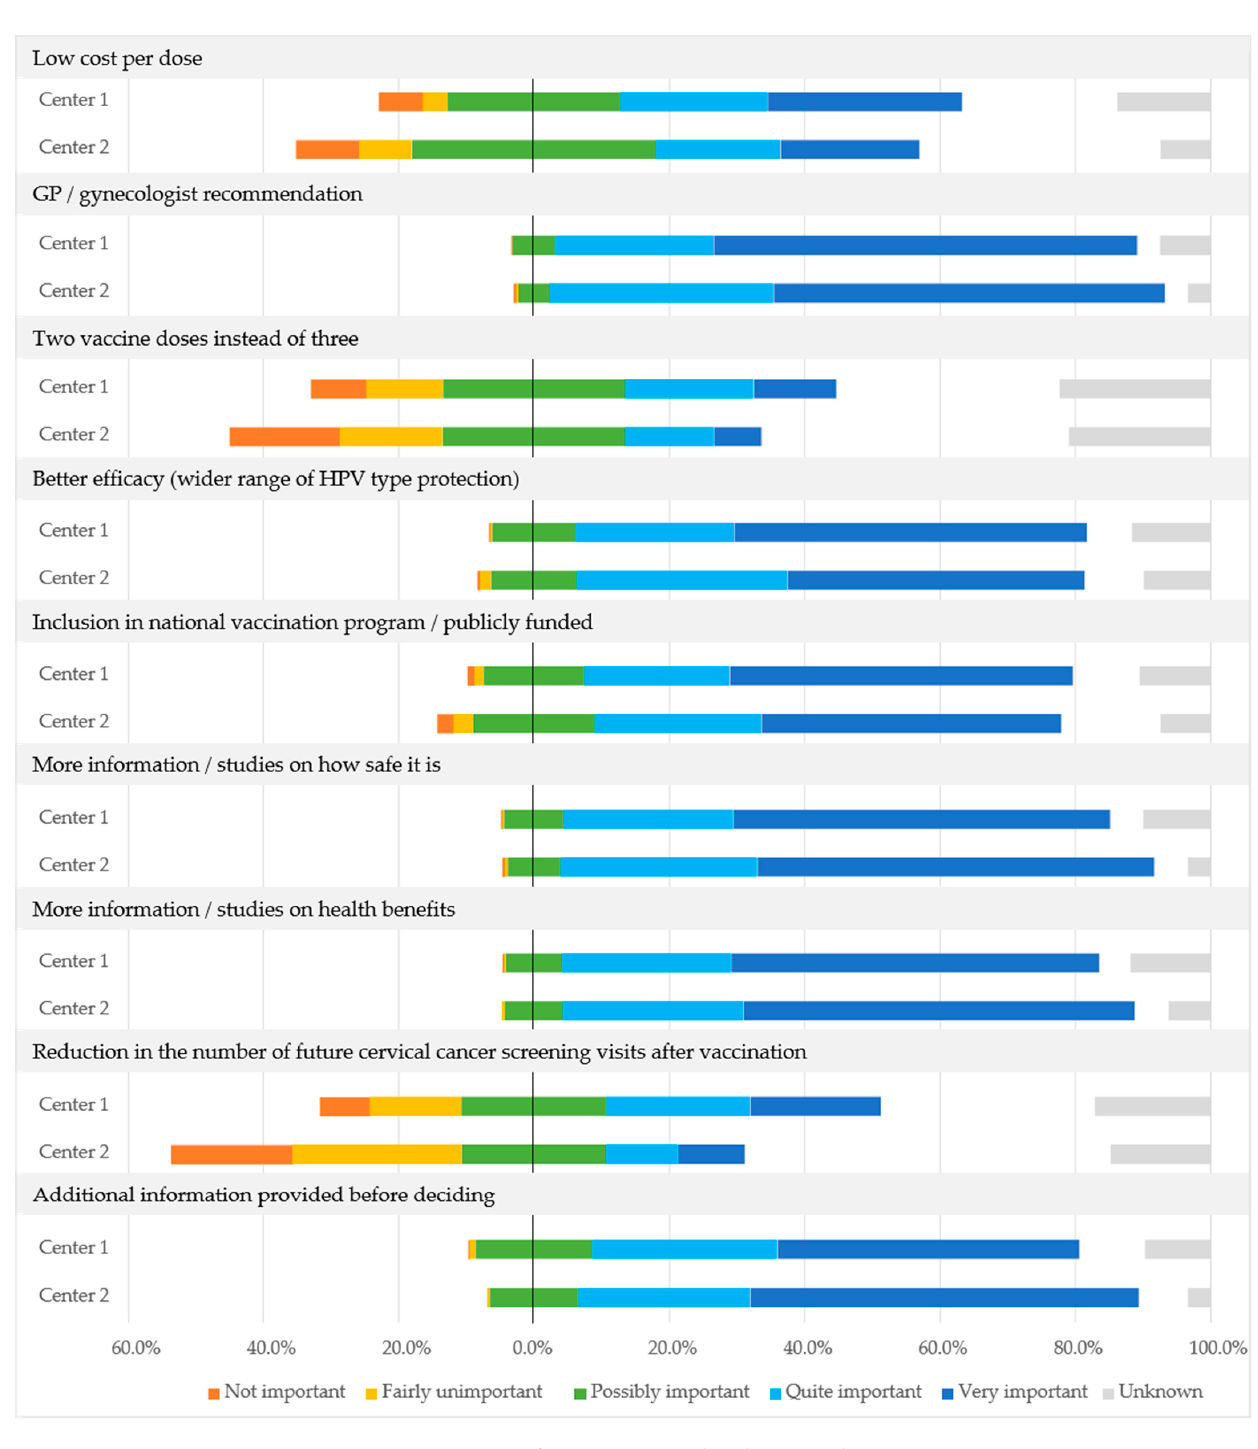
Figure 4. Assessment of HPV vaccine-related issues relevant to improving current HPV vaccination coverage in the Slovenian general population at Center 1 and Center 2, expressed as a proportion of all participants at each center.